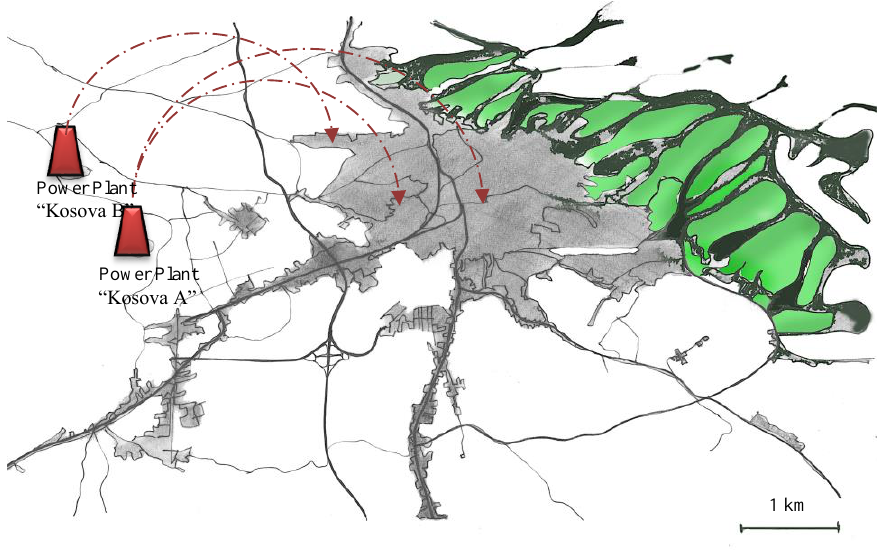
Fig. 2. The city of Prishtina: the land morphology and main polluters, power plants Kosova A and B.